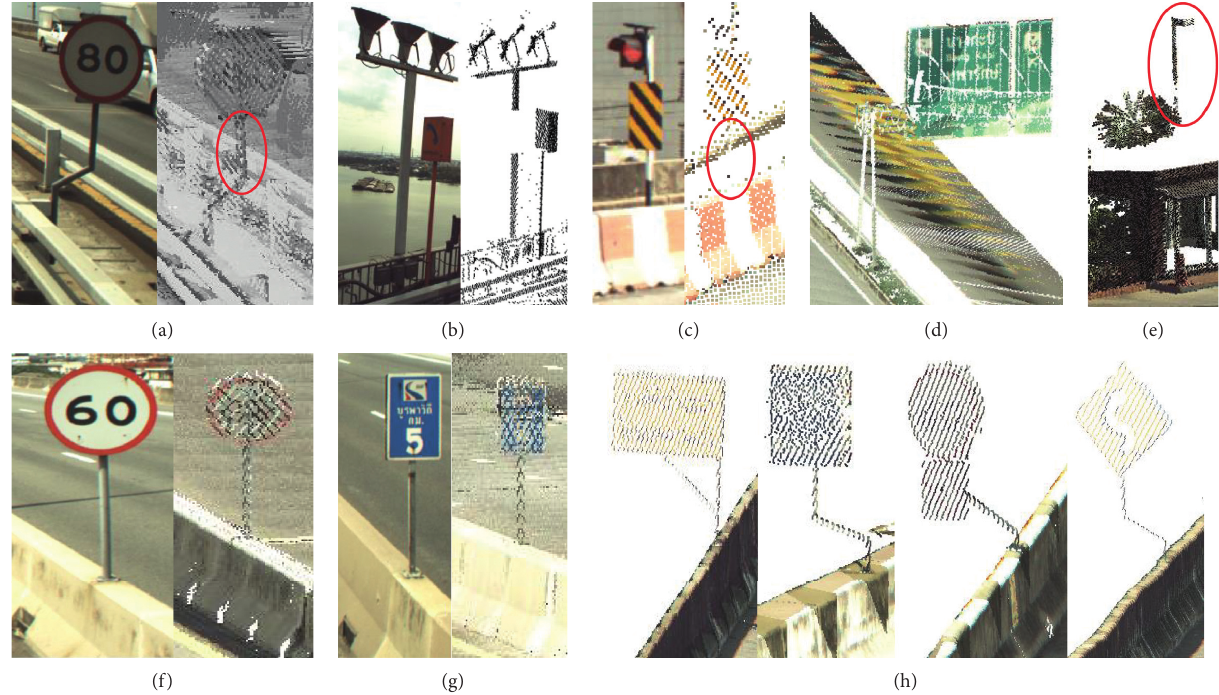
Figure 15: Missing PLO detection (a-b): Site 1 and (c–h): Site 2. (a) Speed limit sign with a short trunk height and a small radius. (b) Telephone pole with the presence of surrounding noise points. (c) Small traffic light with a low density trunk. (d) Overhead sign at a ramp with large inclined poles. (e) Undetected lighting pole. (f) Speed limit sign with a small radius. (g) Kilometer poles with a square section. (h) Some small traffic signs with a short trunk height and a small radius.